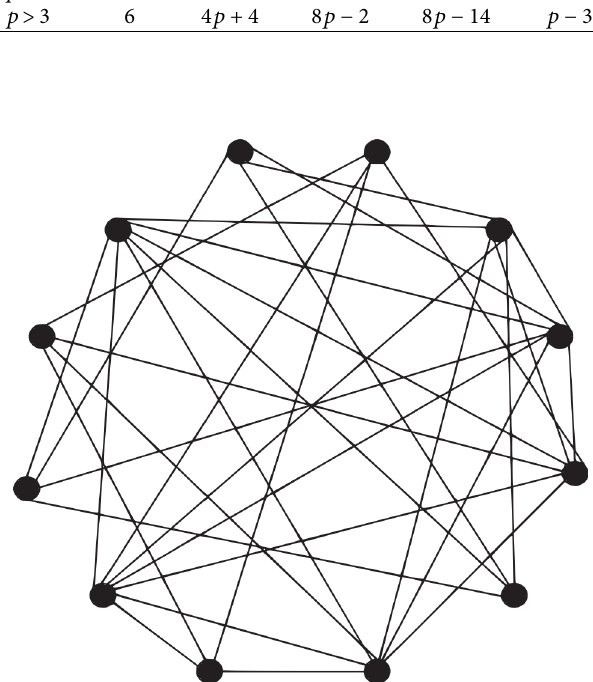
Figure 2: Graph of L ( CS ( 2 ))